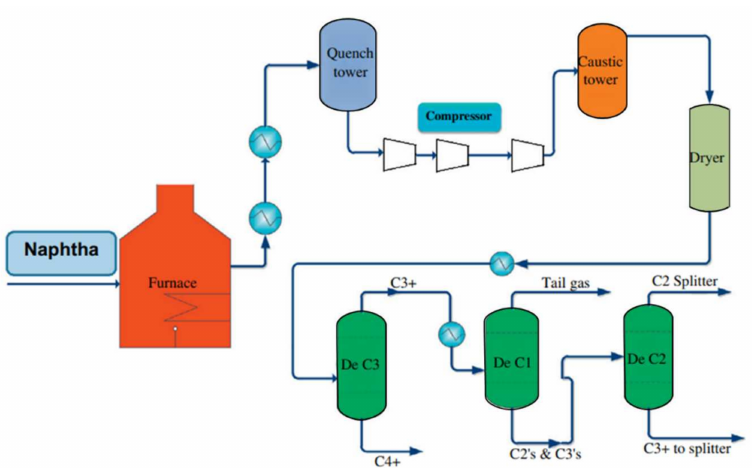
Figure 3. Simplified block diagram for the typical steam cracking process